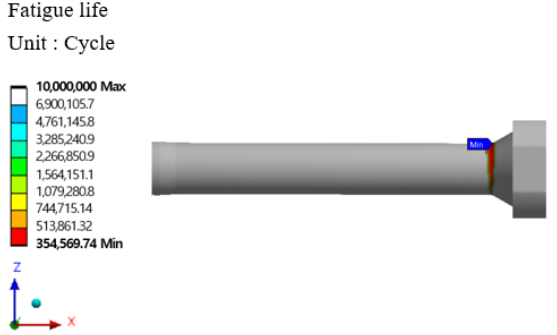
Figure 29. Von-mises stress of stem at 400 °C.